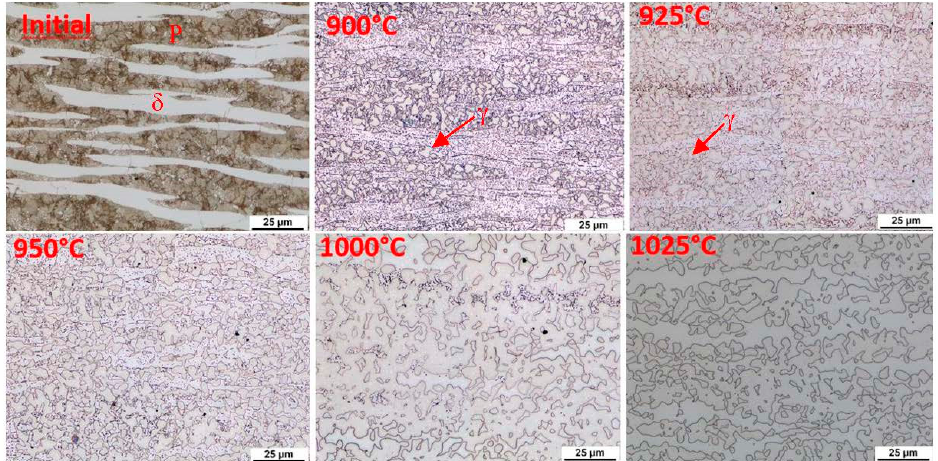
Figure 12. Microstructure of the initial state after different austenitisation temperatures, heat A (5 wt% Al). P—pearlite, δ —ferrite, γ —austenite. (5 wt% Al). P—pearlite, δ —ferrite, γ